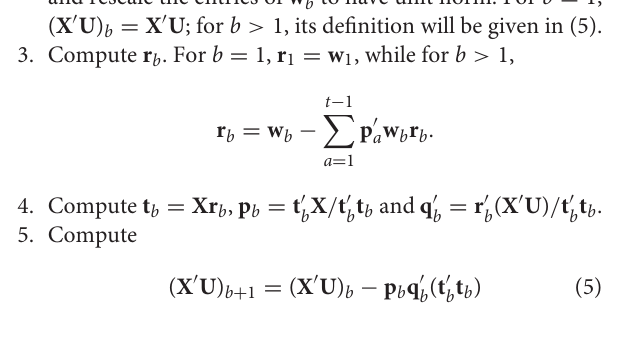
and rescale the entries of w b to have unit norm. For b =